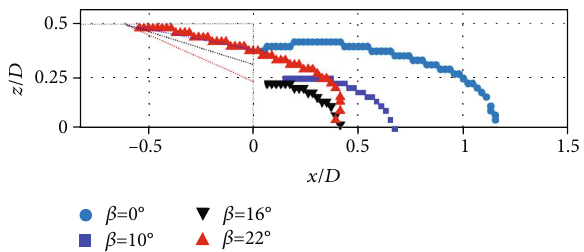
Figure 9: Lines with zero velocity of the wake fl